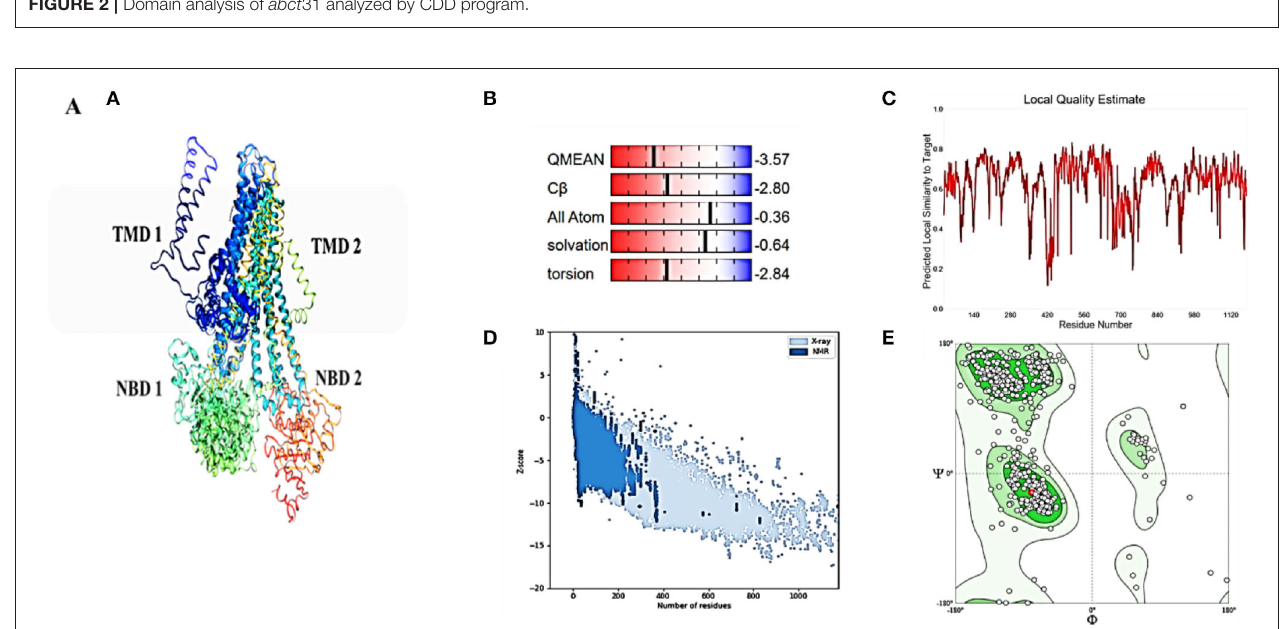
FIGURE 3 | Homology model and checking results for ABCT31 protein. Verification of homology modeling (A) Homology model of ABCT31 protein TMD, Transmembrane domain; NBD, Nucleotide-binding domains; (B) Plot displaying the model’s normalized Q mean score; (C) Plot displaying the model’s local quality; (D) Z score value of the model developed; (E) Ramachandran plot validating the energy-minimized model’s backbone dihedral angles.